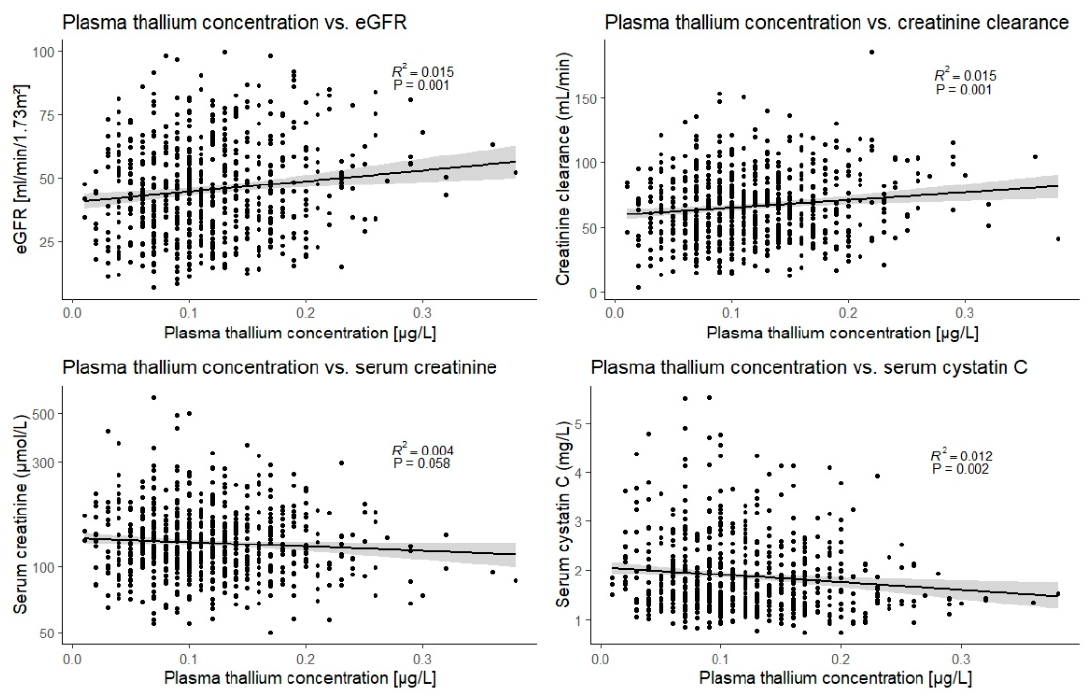
Figure 1. Scatter plots and visual presentation of the univariable linear association of plasma thallium concentration with the parameters of kidney function.